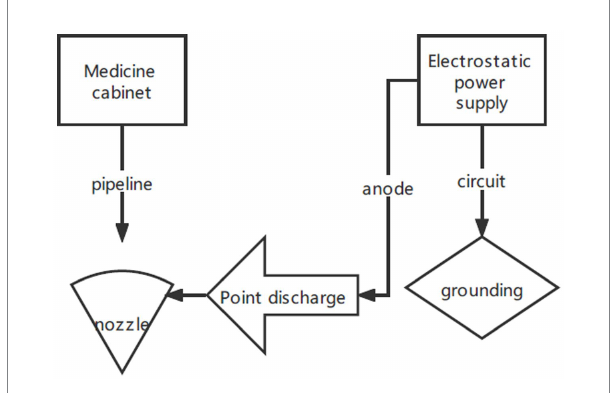
FIGURE 2 Corona charging schematic diagram.